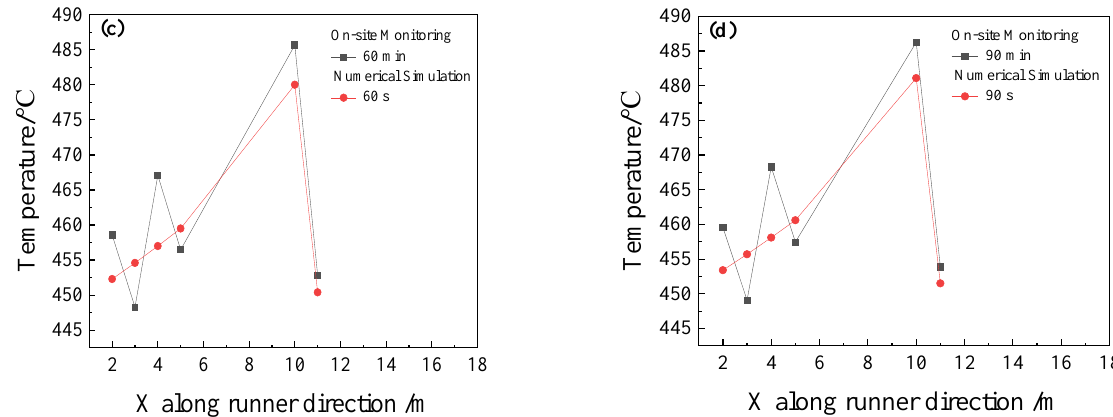
Figure 8. Temperature comparisons in the simulations and in plant measurements at four different times: ( a ) 0 s,0 min; ( b ) 30 s,30 min; ( c ) 60 s,60 min; and ( d ) 90 s,90 min.